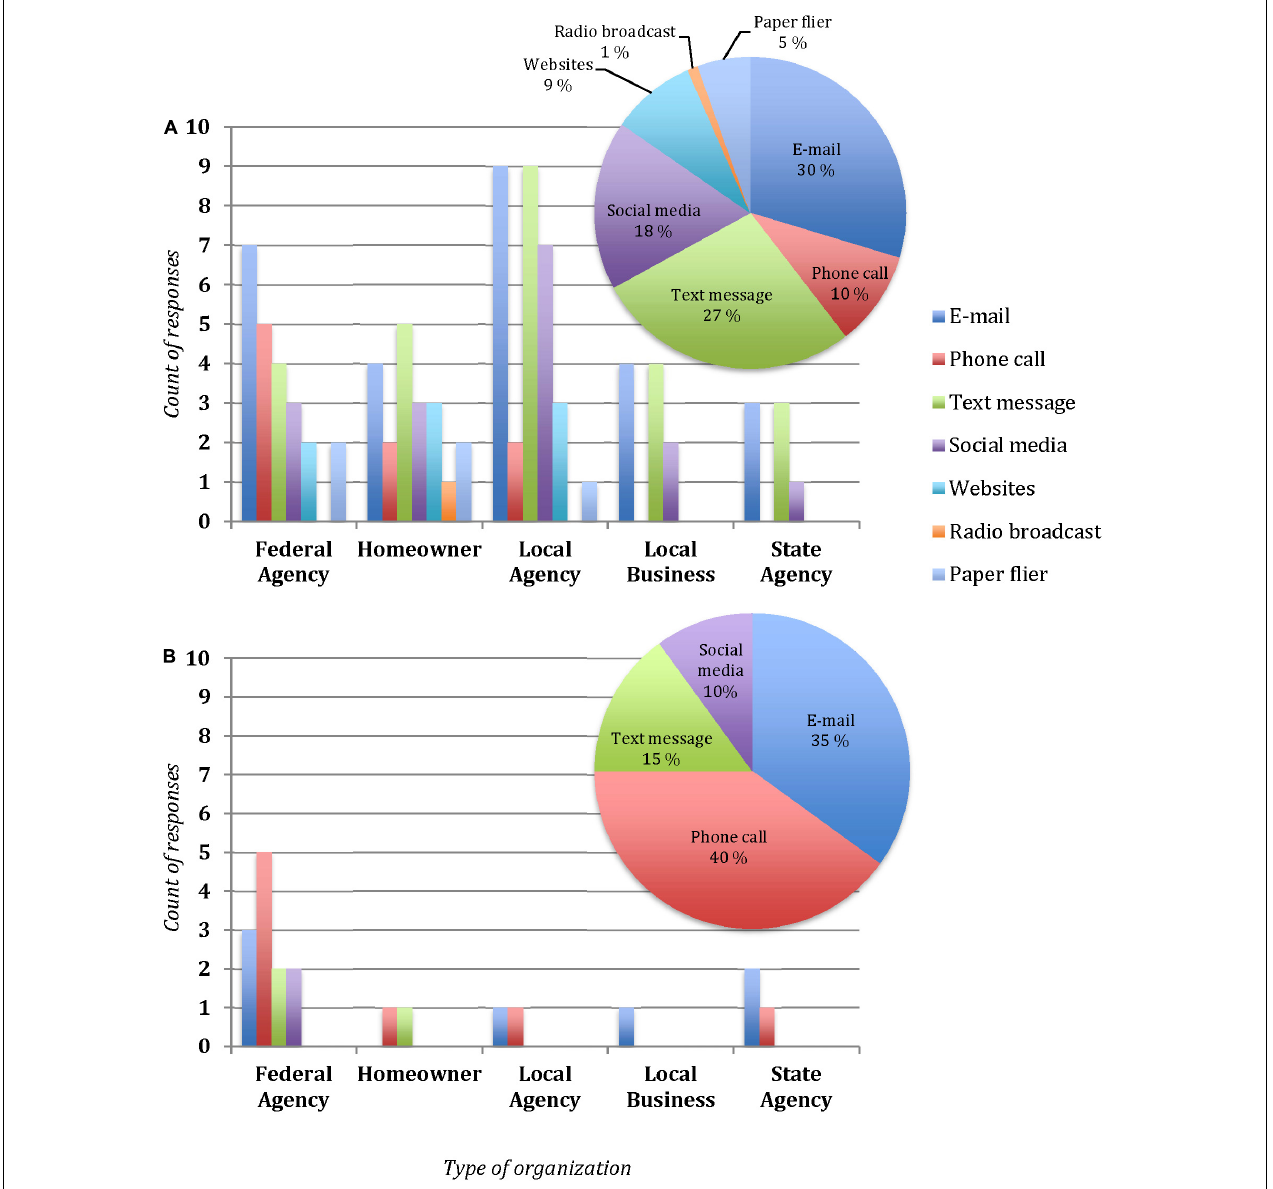
FIGURE 2 | Preferred media to receive GLOF information by type of organization for (A) Juneau interviewees ( n = 35) and (B) Kenai Peninsula interviewees ( n = 13). Interviewees could list multiple preferred media, thus number of responses exceed number of interviewees. The pie chart is an aggregated representation of all interviewee responses in each case,